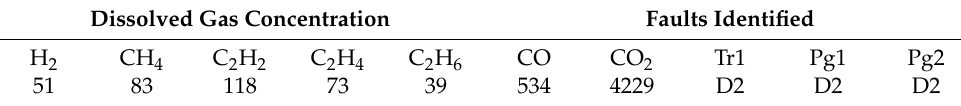
Table 14. DGA analysis and fault identification.